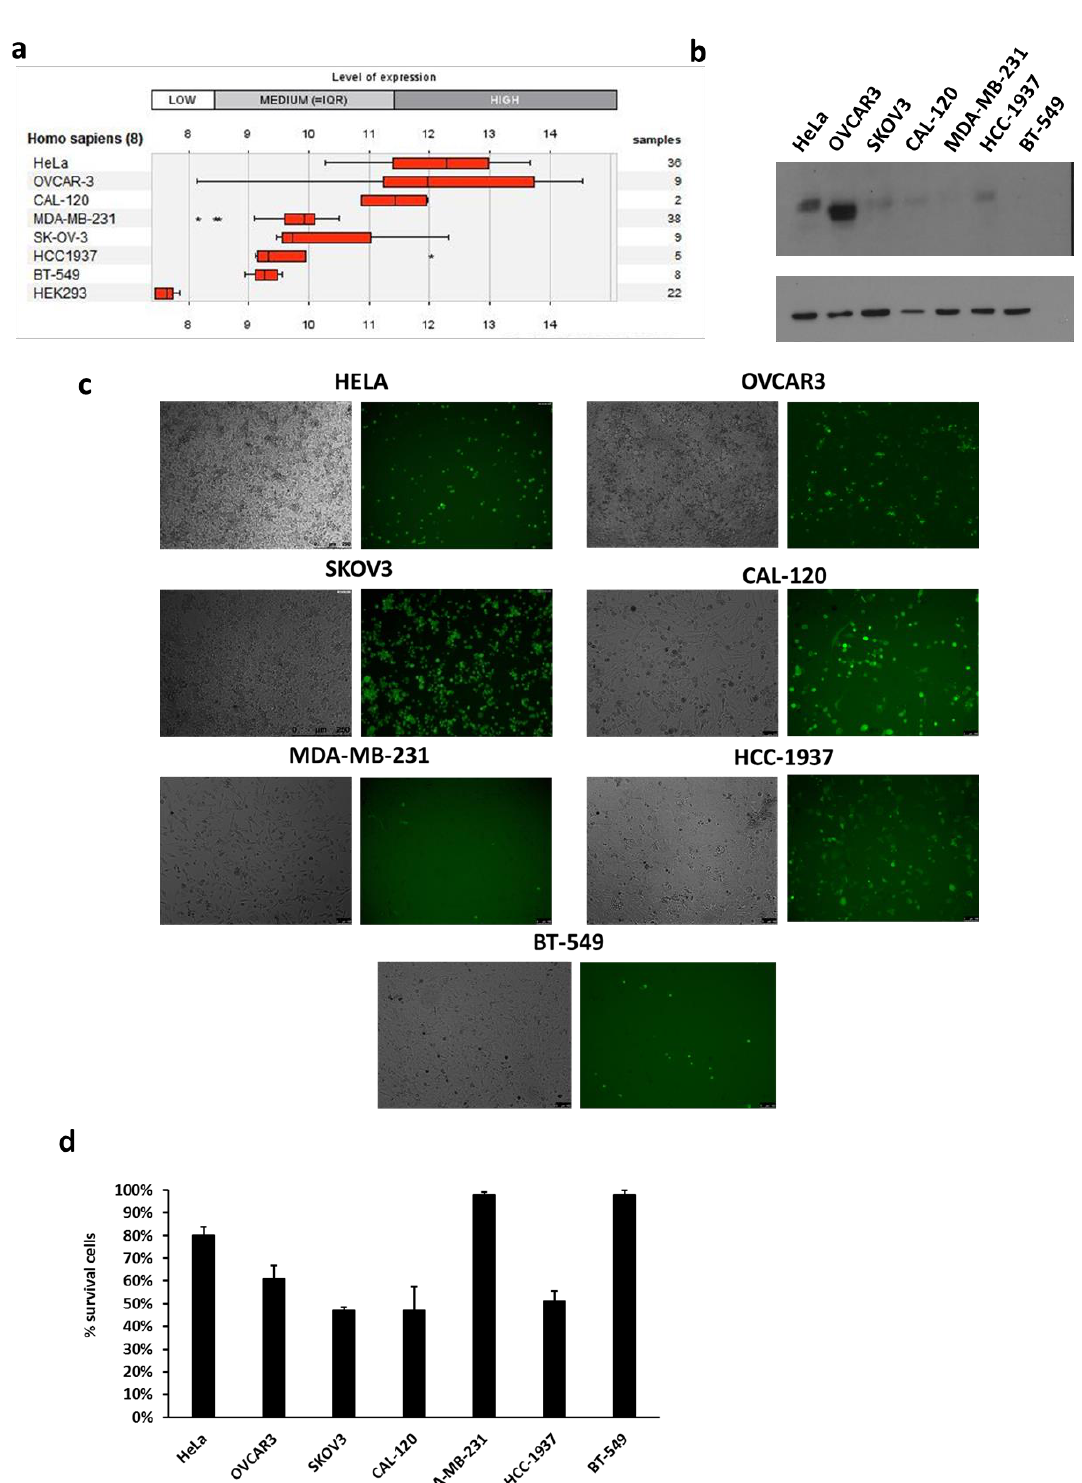
Figure 4. THV_SS1 infects breast and female reproductive system tumor cells in a MLSN-dependent manner. ( a ) Mesothelin expression assessed by GENEVESTIGATOR software by interrogating RNAseq repository of breast (CAL-120, HCC-1937, BT-549, MDA-MB-231) and female reproductive system (OVCAR3, HeLa, SKOV3) tumor cell lines. ( b ) MSLN expression in selected cell lines was evaluated by Western blot and gamma-tubulin was used as standard. ( c ) Infection and ( d ) cytotoxicity of THV_SS1 in tumor cell lines were assessed respectively by fluorescence/bright-field microscopy and trypan blue positive cells.